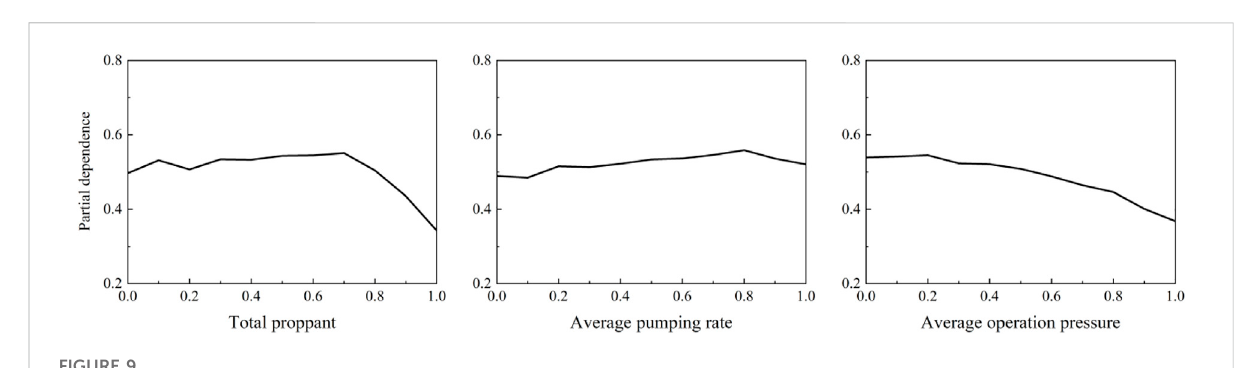
FIGURE 9 Partial dependency plot of engineering parameters(C) of GEP